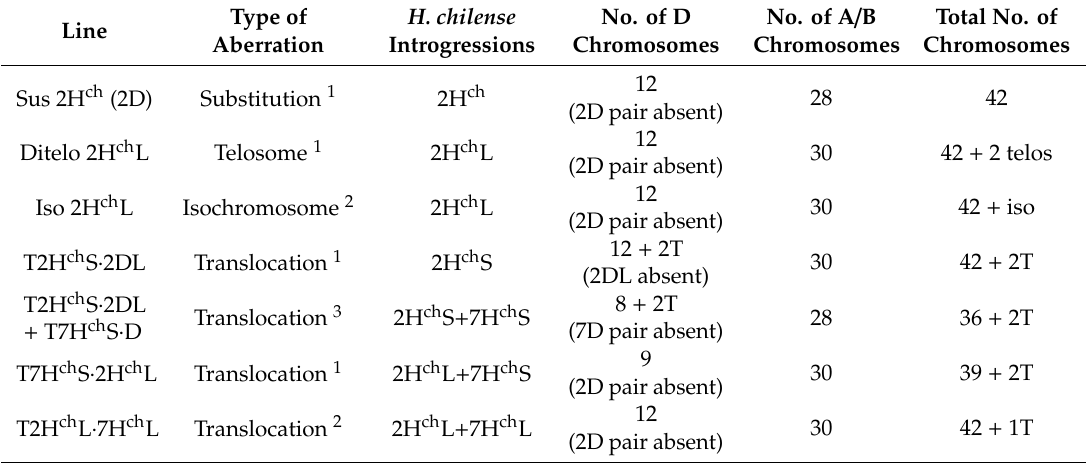
Table 1. Chromosome constitutions of wheat— H. chilense introgression lines involving chromosome 2H ch .